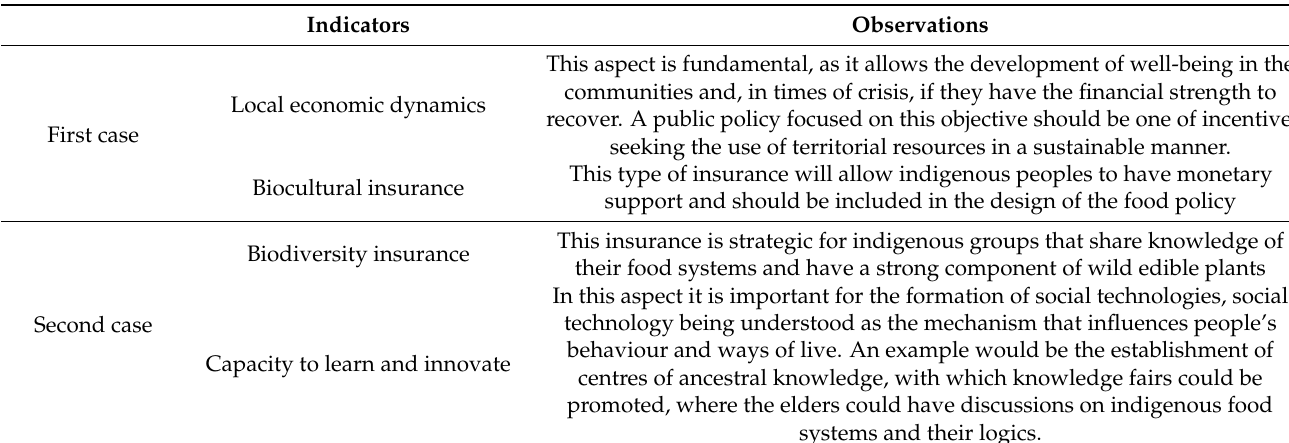
Table 2. Indicators in food